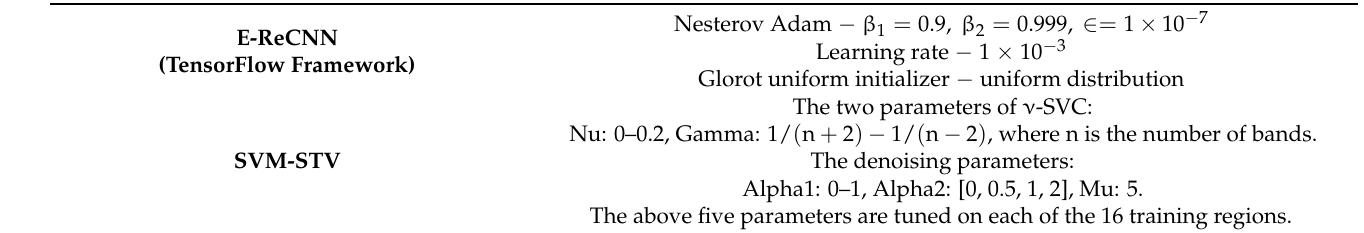
Table A2. Configuration of optimal model parameters for supervised (E-ReCNN) and semi- supervised (SVM-STV)